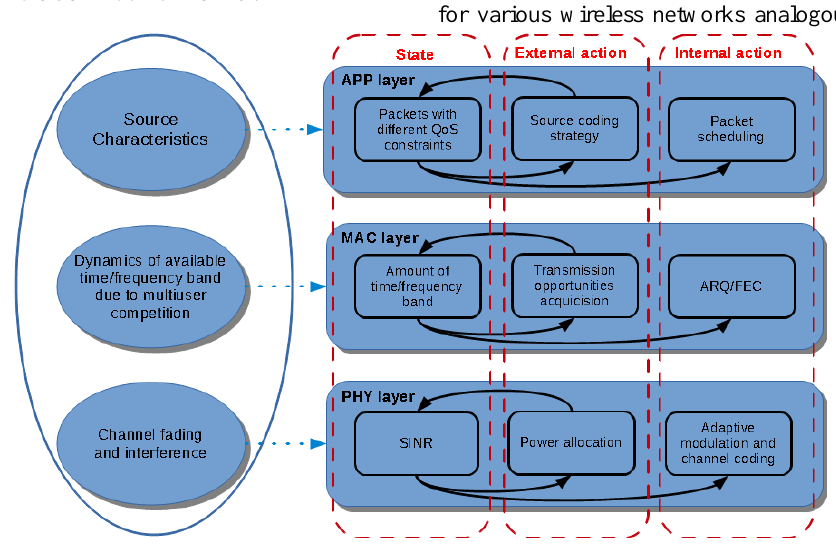
Figure 2. Layered cross-layer optimization